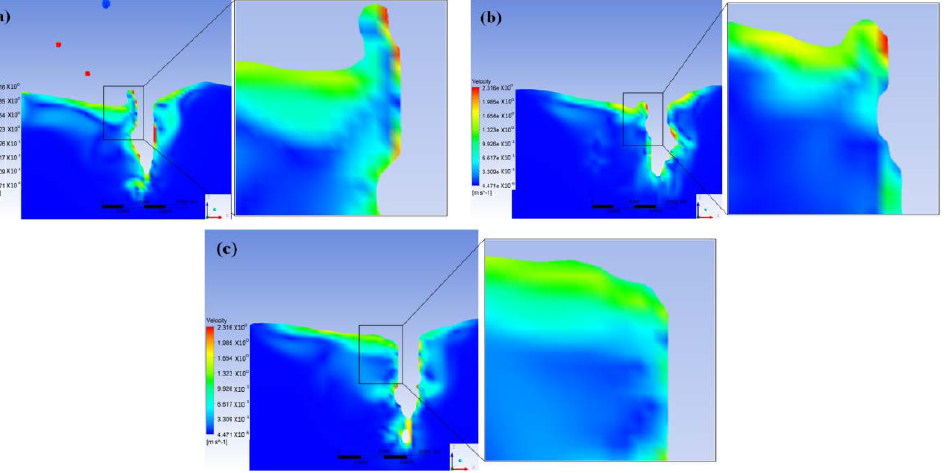
Figure 10. Flow velocity nephogram of molten pool when the welding time is 29 ms: ( a ) the preheating temperature is 300 K (ambient temperature), ( b ) the preheating temperature is 400 K, ( c ) the preheating temperature is 500 K.